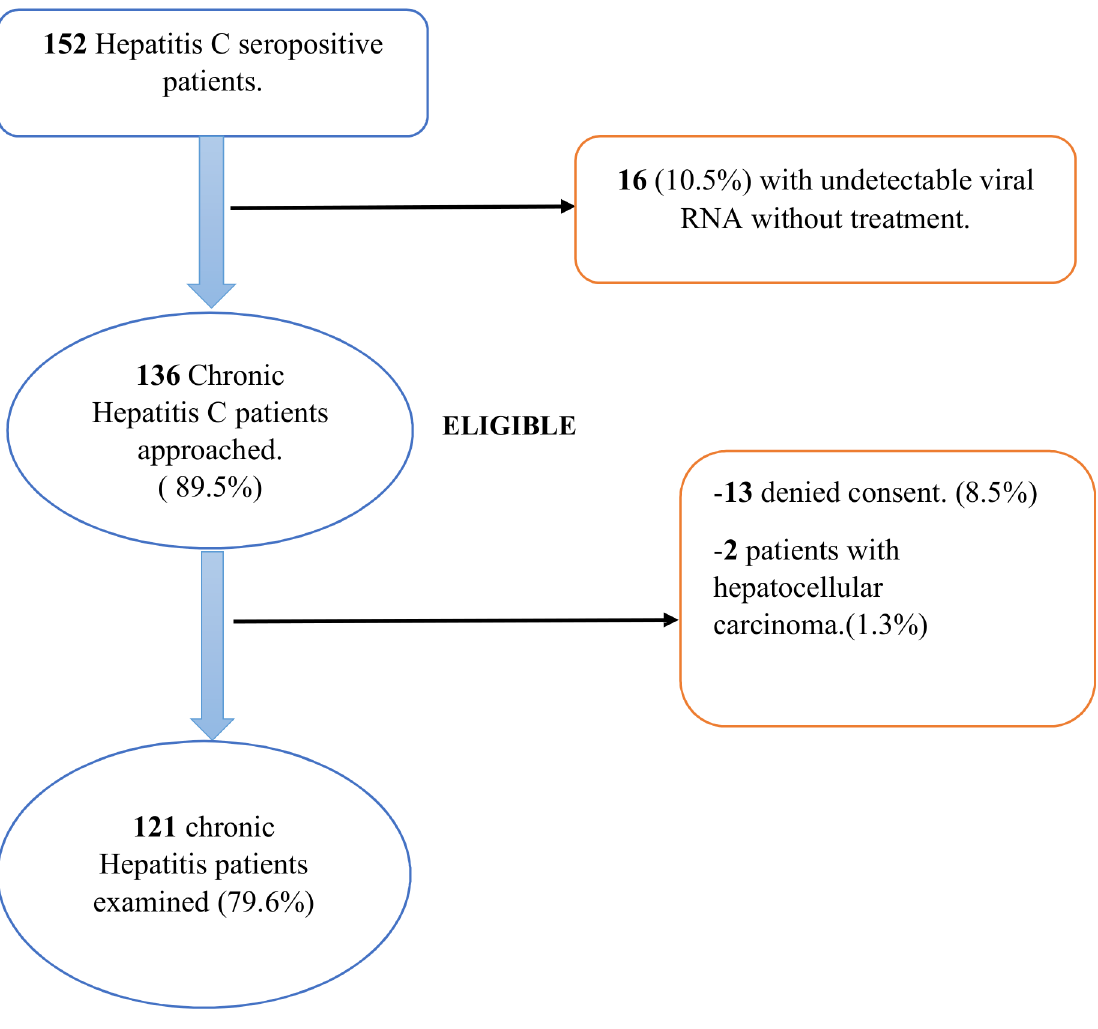
Fig 1. Flow chart of patient